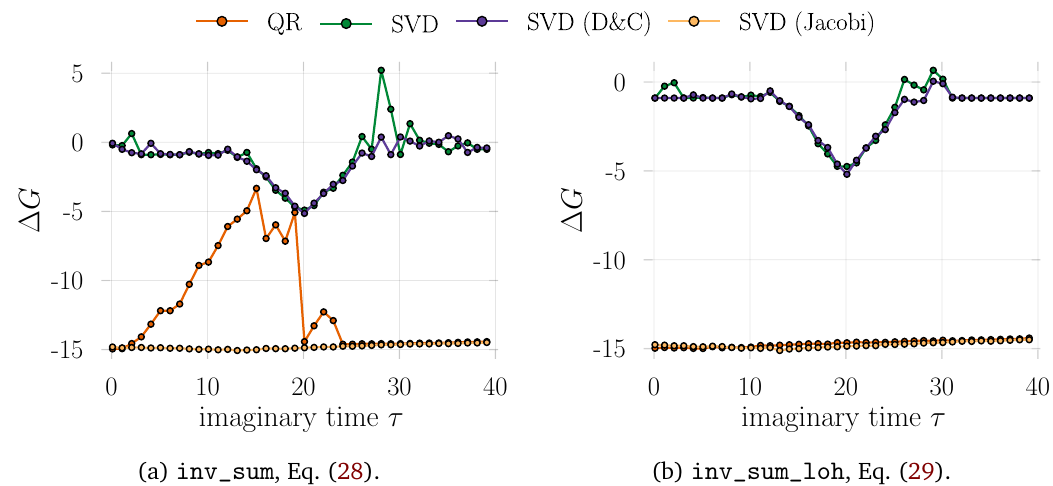
Figure (6) Accuracy of the time-displaced Green’s function obtained from sta- bilized computations using the listed matrix decompositions and inversion schemes. ( τ ,0 )))) for β = Shown is ∆ G = log ( max ( abs ( G ( τ ,0 ) − G exact